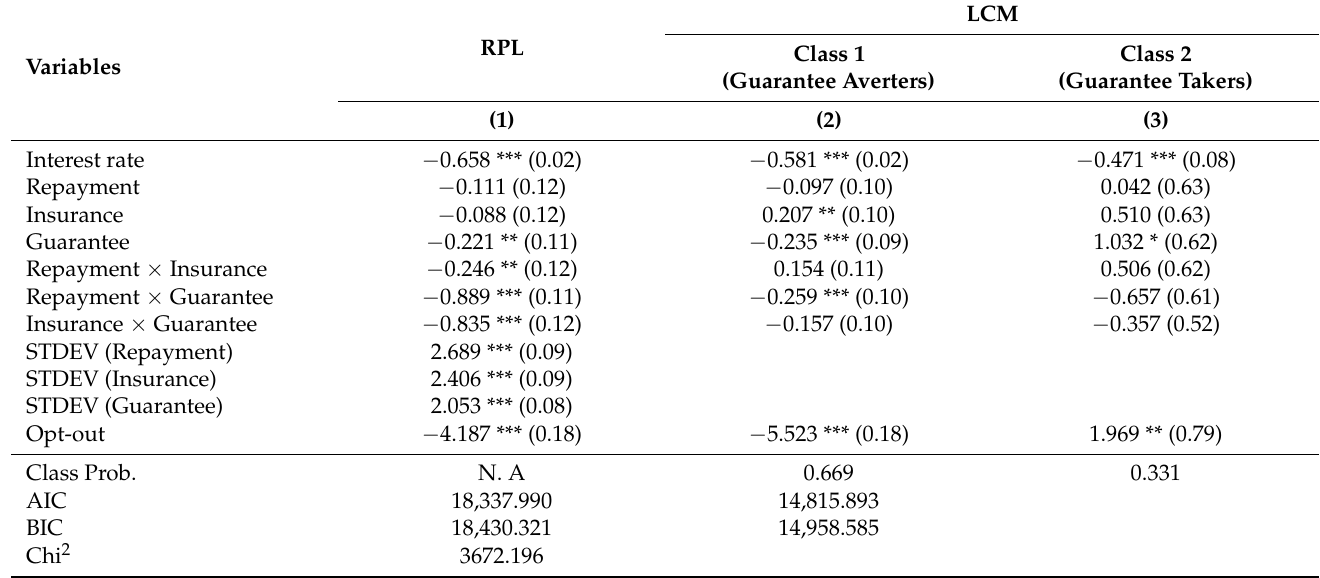
Table 3. The estimations of the RPL and